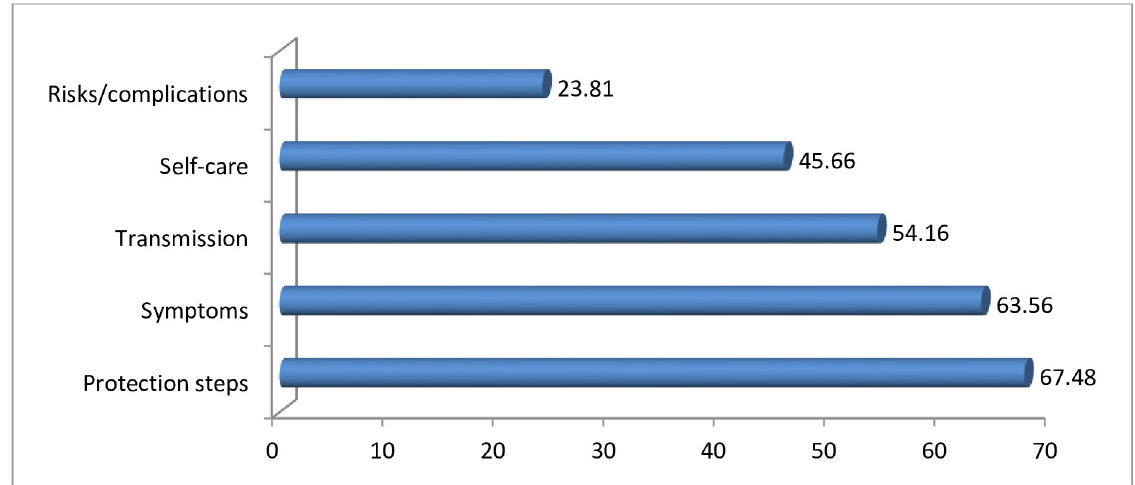
Fig 5. Percentage on kinds of information on COVID-19, Oromia region, Ethiopia, September 2020 to March 2021. NB: Percentage may not add 100% as multiple responses were possible.